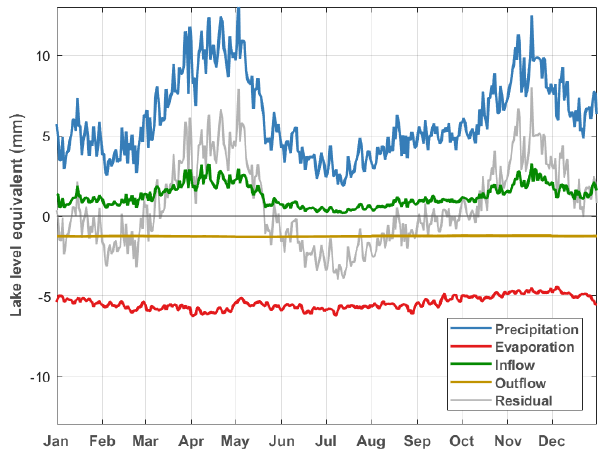
Figure 7. Seasonal cycle of the water balance (WB) terms and resid- ual for the period 1993–2014.